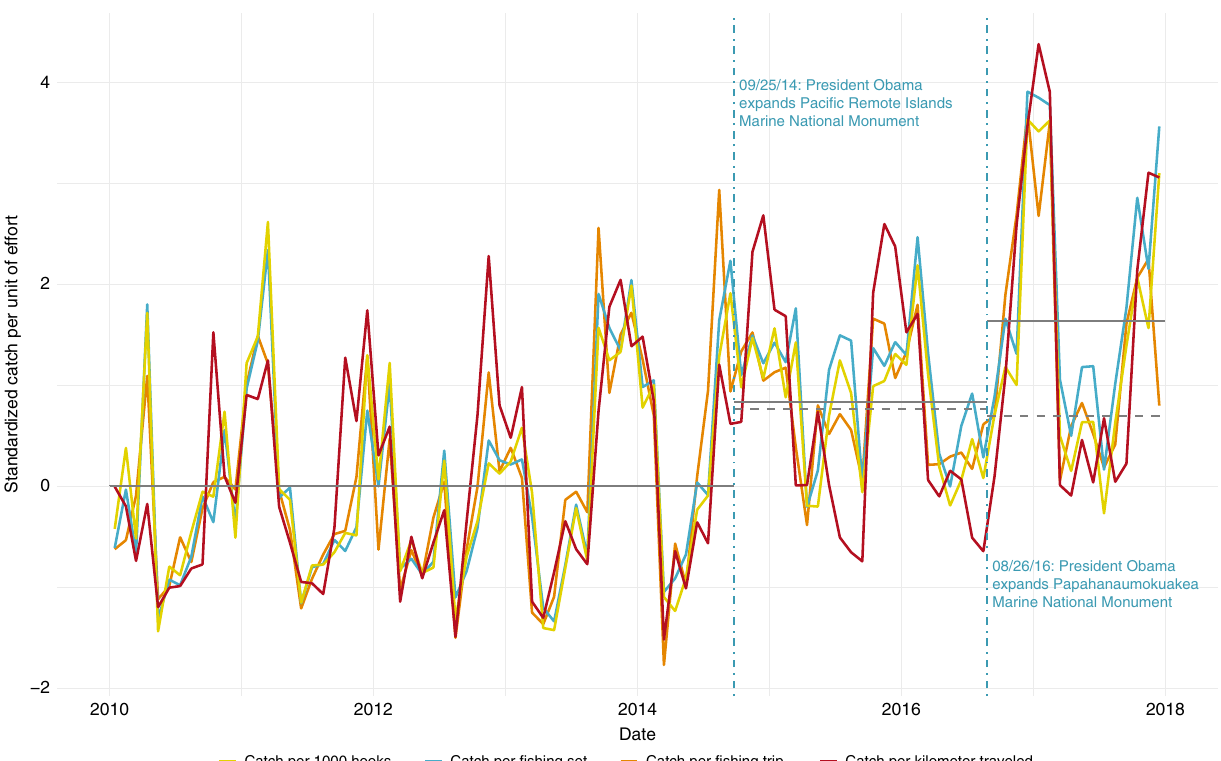
Fig. 4 Monthly CPUE pre- and post-expansions for the Hawaii-based tuna fl eet. The four catch-per-unit-effort (CPUE) measures are catch-per-1000-hooks (solid yellow line), catch-per- fi shing set (solid blue line), catch-per- fi shing-trip (solid orange line), and catch-per-kilometer-traveled (solid dark red line). Vertical dashed blue lines indicate the dates of the two expansions. Each time series has been standardized by subtracting its mean value prior to the PRI expansion and dividing by its standard deviation prior to the PRI expansion. The horizontal solid gray lines indicate the mean of all four catch-per-unit-effort measures (i) prior to the expansion, (ii) following the PRI but prior to the PMNM expansion, and (iii) following the PMNM expansion. The horizontal dashed gray lines represent the same calculation (the mean of all four standardized catch-per-unit-effort measures) for two control fi sheries: the segment following PRI expansion but prior to PMNM expansion is calculated using Hawaii sword fi sh fl eet data and the post-PMNM segment is calculated using American Samoa tuna fl eet data. Both segments are standardized relative to their means and standard deviations prior to the PRI expansion. All lines are drawn for the purposes of motivation and data visualization only. For appropriate tests of statistically signi fi cant differences, please refer to the regression tables.